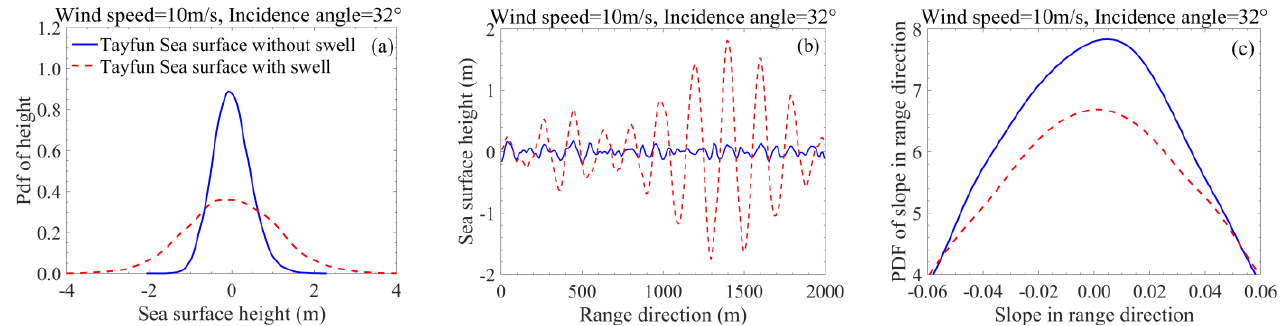
Figure 14. Comparison of Tayfun sea surface without and with swell at 10 m/s wind speed and 32° incidence angle in the upwind direction. The significant wave height of swell = 4 m, swell wave- lengths = 20 m, and the swell direction is upwind. ( a ) Pdfs for surface elevations; ( b ) profiles of surface elevations along range direction; ( c ) pdfs for slopes along range direction. Blue solid curve, sea surface without swell; red dashed curve, sea surface with swell.